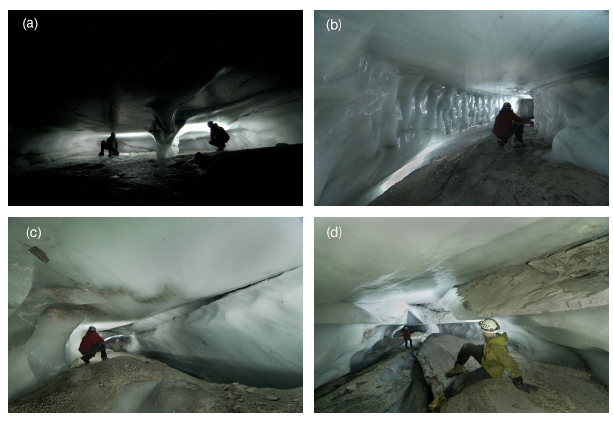
Figure 5. Passage morphology in NG-04. (a) Cut-off meander loop; note the inclined debris band on back wall behind the left-hand per- son. (b) The upper passage near A12, showing suture between the right-hand wall and the ceiling, and the incised lower passage on the left. (c) The upper passage near A7, with a void and suture between the right-hand wall and the ceiling. (d) The upper passage near A6, showing a band of bedded sand filling a sub-horizontal suture above the foreground person.